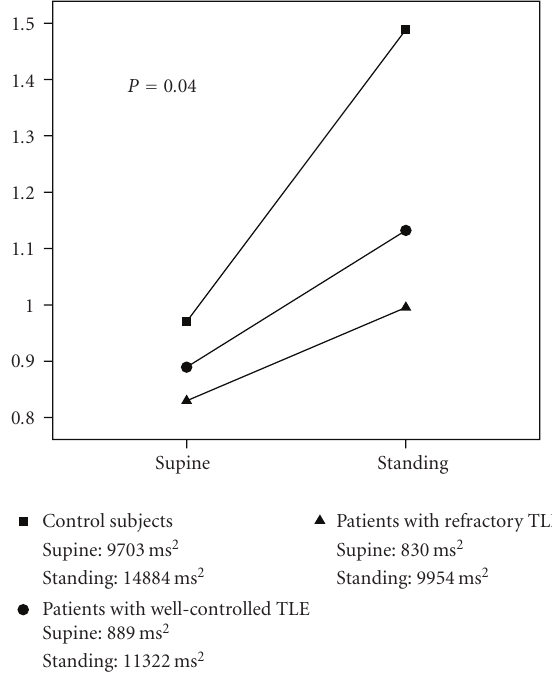
Figure 1: The change of total power from supine to standing in patients with refractory temporal lobe epilepsy (triangles), in patients with well-controlled temporal lobe epilepsy (circles), and the control subjects (squares). The values are estimated marginal means. The P - value describes the significance of the di ff erence of the change from supine to standing position between the patient groups and the control